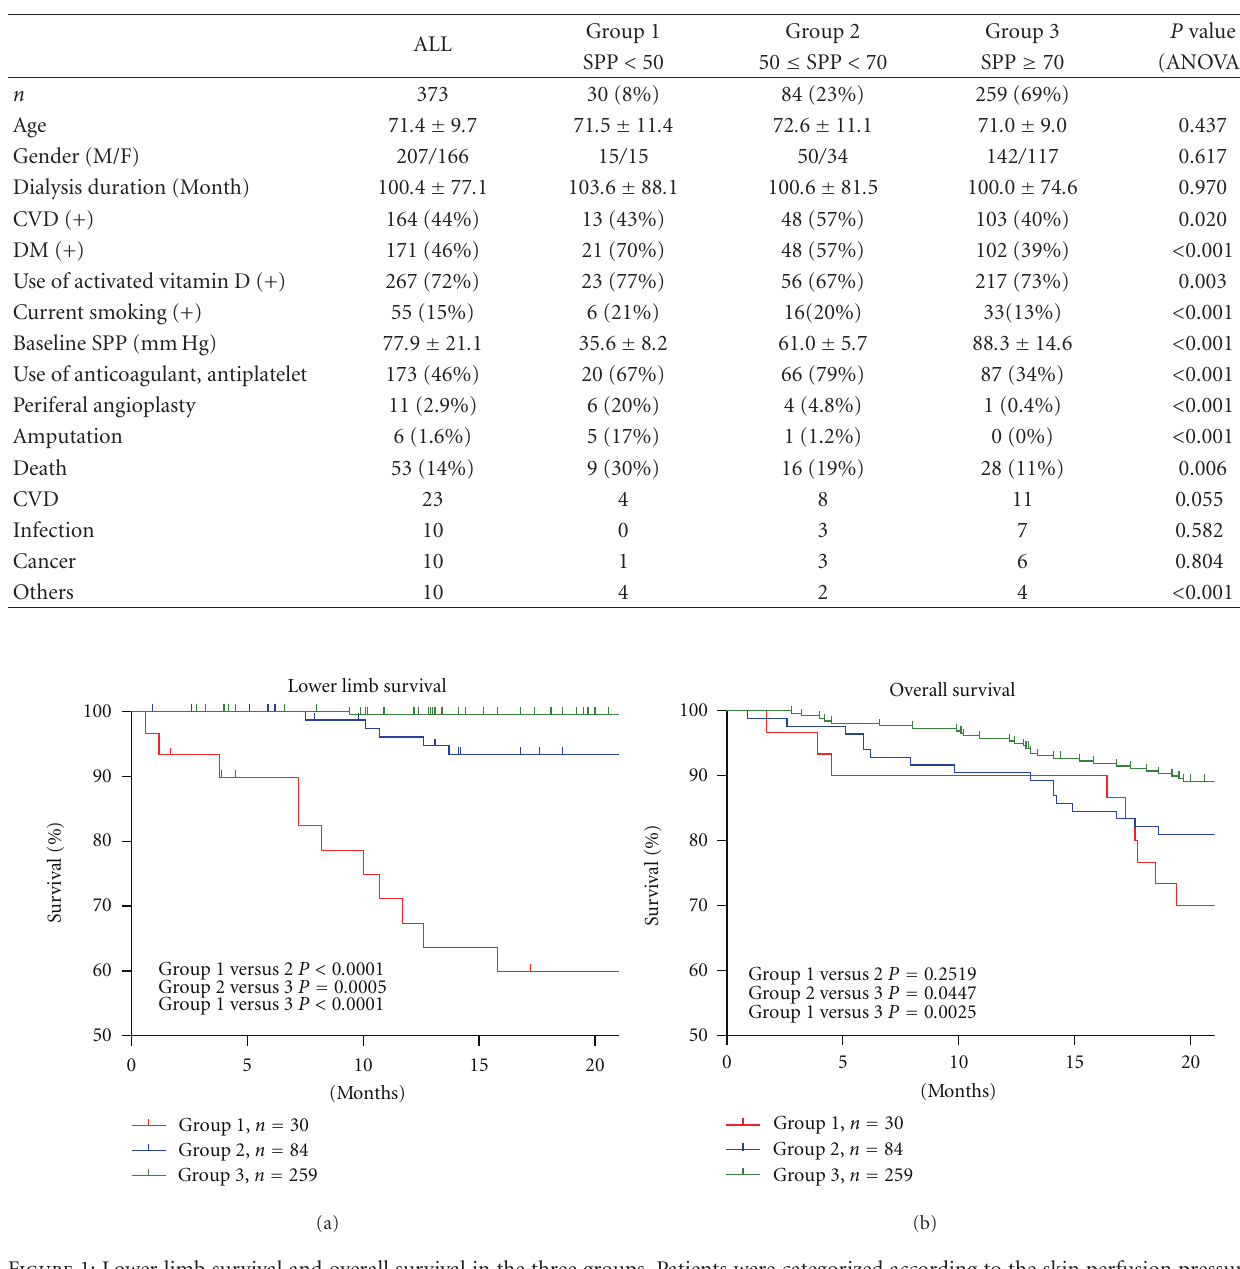
Table 1: Characteristics of the 373 hemodialysis patients. We categorized the patients into three skin perfusion pressure (SPP) groups: Group 1, < 50; Group 2, 50 ≤ SPP < 70; and Group 3, SPP ≥ 70, based on a healthy SPP value from volunteers. P value refers to overall ANOVA or chi-square analysis.